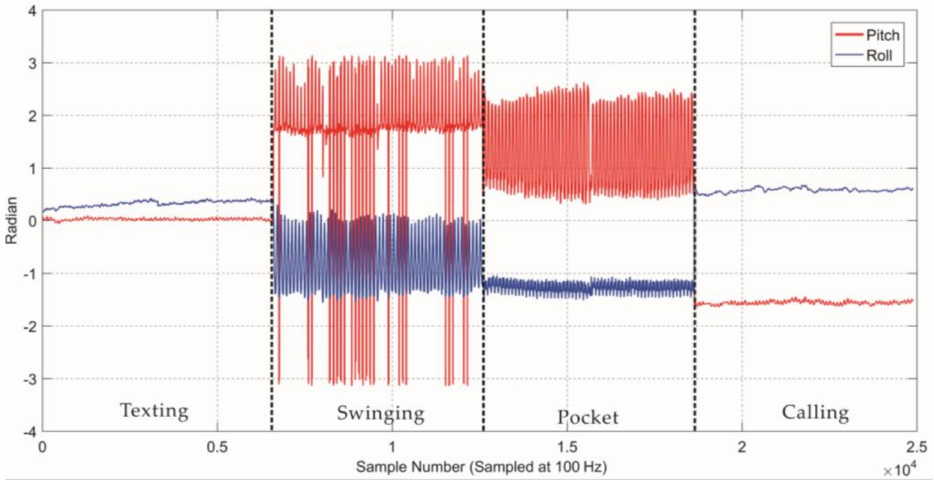
Figure 4. Example of the pitch and roll data in different poses. Table 1. Descriptions of the